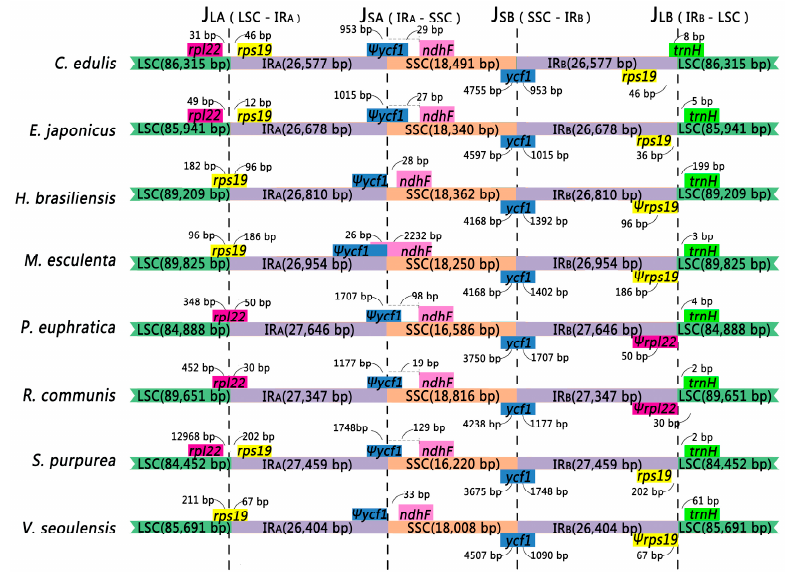
Figure 2. Comparison of junctions between the LSC, SSC, and IRs among eight species. Number above indicates the distance in bp between the ends of genes and the borders sites (distances are not to scale in this figure). The ψ symbol represents pseudogenes.